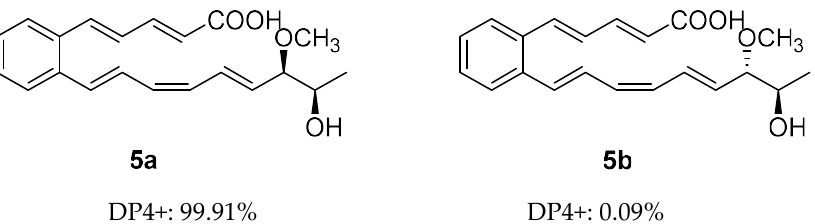
Figure 3. DP4+ probability of two plausible epimers 5a and 5b of 5 ( 5a : rel-(18 S ,19 S ), 5b: rel- (18 S ,19 R )).